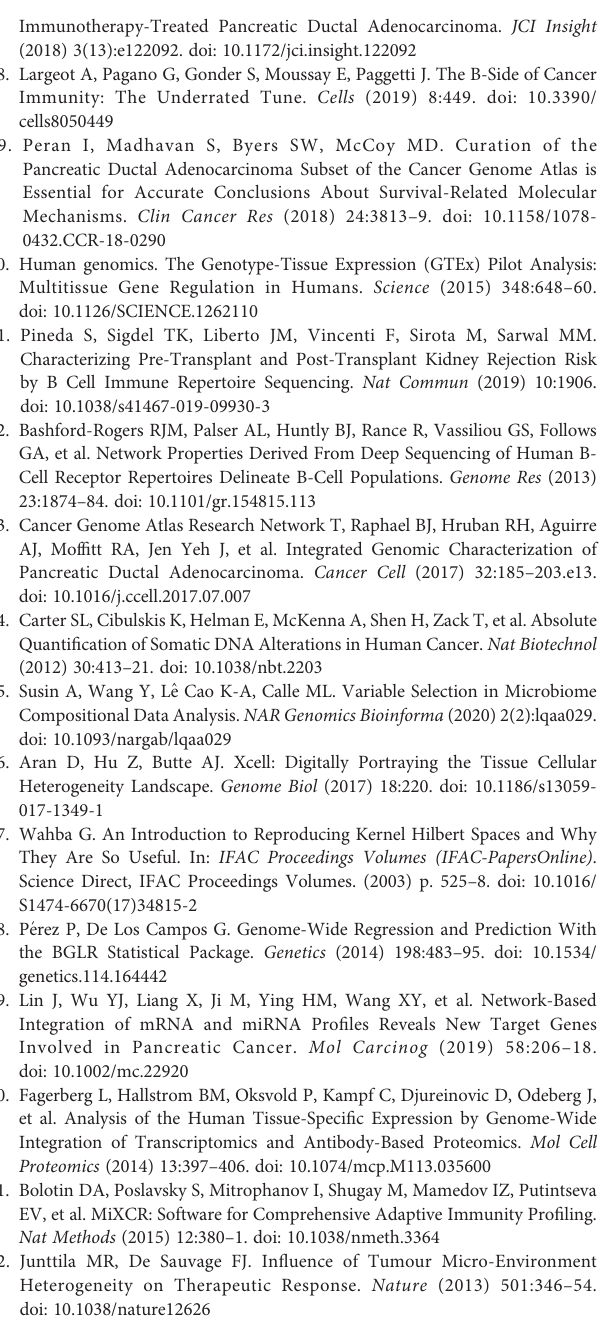
calculated in its corresponding sampled dataset. The same processed was repeated 10 times in each proportion to avoid possible stochastic effects and calculated the mean value as the fi nal estimate. Supplementary Figure 4 | Boxplots with the association between IG and TCR with subtypes of pancreatic cancer de fi ned by Bailey, Collison, and Mof fi t. Supplementary Figure 5 | Similarity matrix between samples based on the IGK clonotypes calculated by linear kernel. IGK clonotypes based variance explained 24% of the prognostic phenotypic variance calculated using